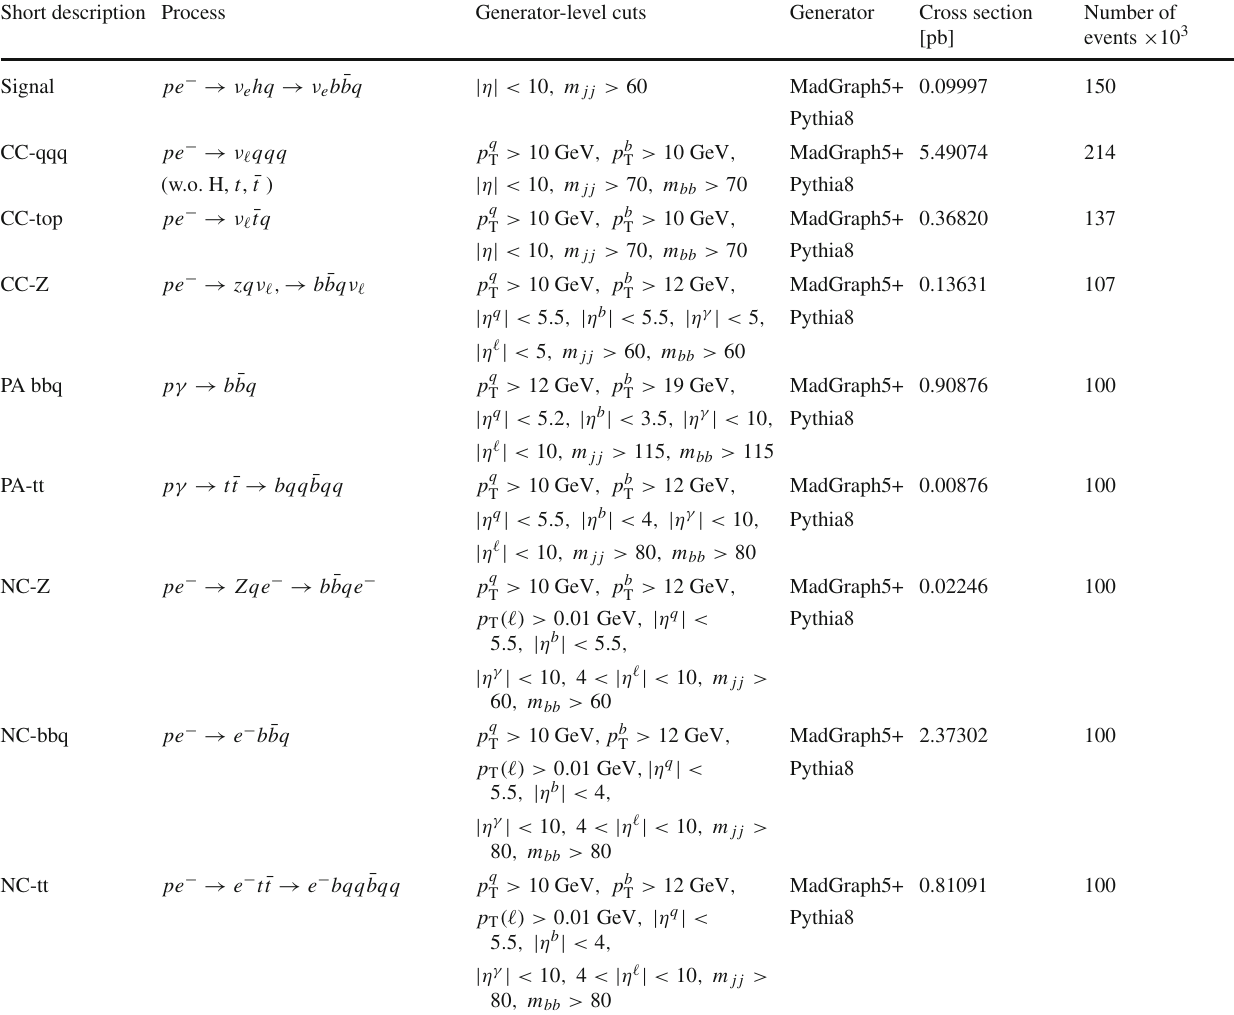
top quark and (cid:7) = ( e ± ,μ ± ) . Whenever we mention b -quark (anti- b - quark) we specify that the generator has at least the same number of b -quarks (anti b -quarks) at the parton